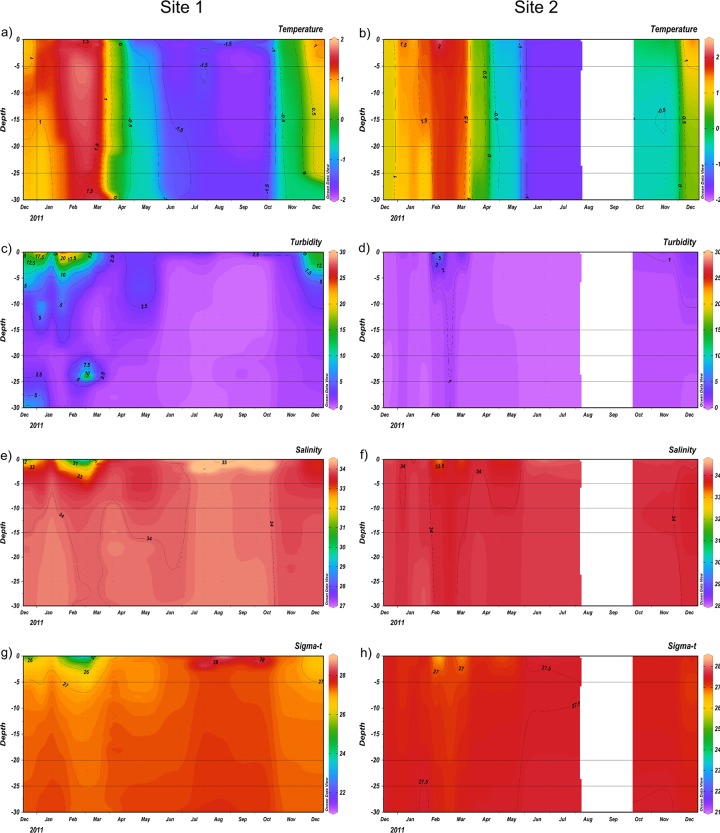
The CTD profiles.Spatial and temporal dynamics of oceanographic variables at Site 1-Site 2; showing water temperature (Fig 2A and 2B), turbidity (Fig 2C and 2D), salinity (Fig 2E and 2F), and sigma (Fig 2G and 2H).